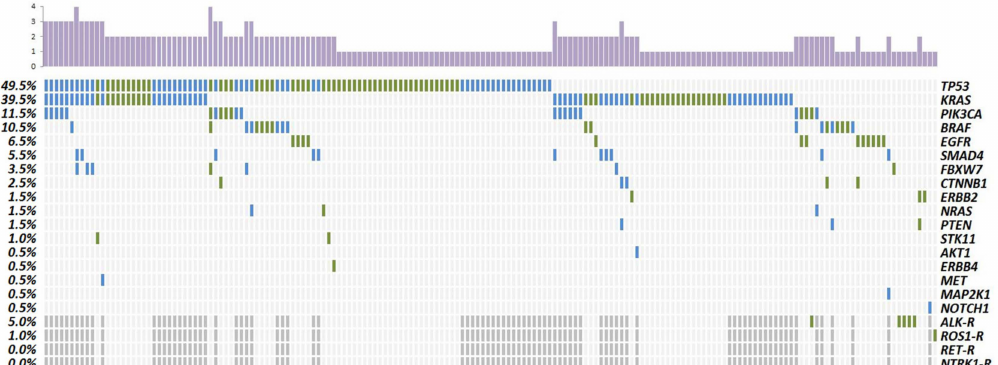
Figure 1. Distribution of gene alterations in NSCLC (green) and mCRC patients (blue). Column chart in the upper part represents the total number of mutations for each sample. Left column indicates the percentage of samples with specific gene alteration. Dark grey—Not tested.